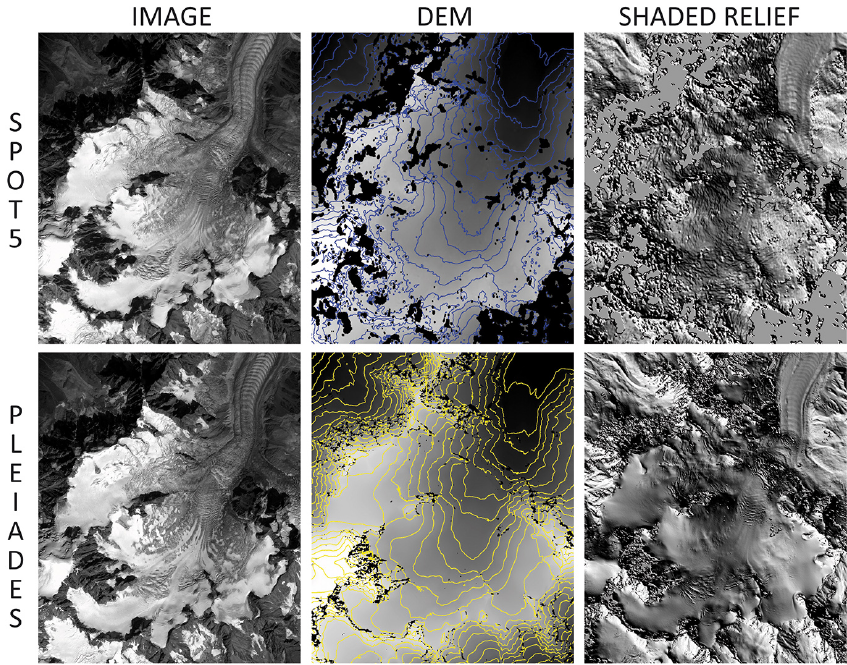
Figure 4. Comparison of the 21 August 2003 SPOT 5 and 19 August 2012 Pléiades DEMs of the accumulation basin of the Mer de Glace. The upper panels show the SPOT 5 data and the lower panels the Pléiades data. From left to right, the panels show successively the satellite images, the DEMs with the 50m elevation contour lines and the shaded relief images derived from the DEMs. Note the higher percentage of data voids and artefacts in the SPOT 5